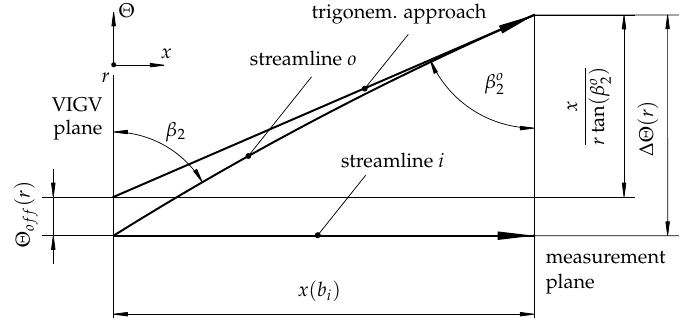
Figure 6. Approach of the circumferential correlation at the radius r